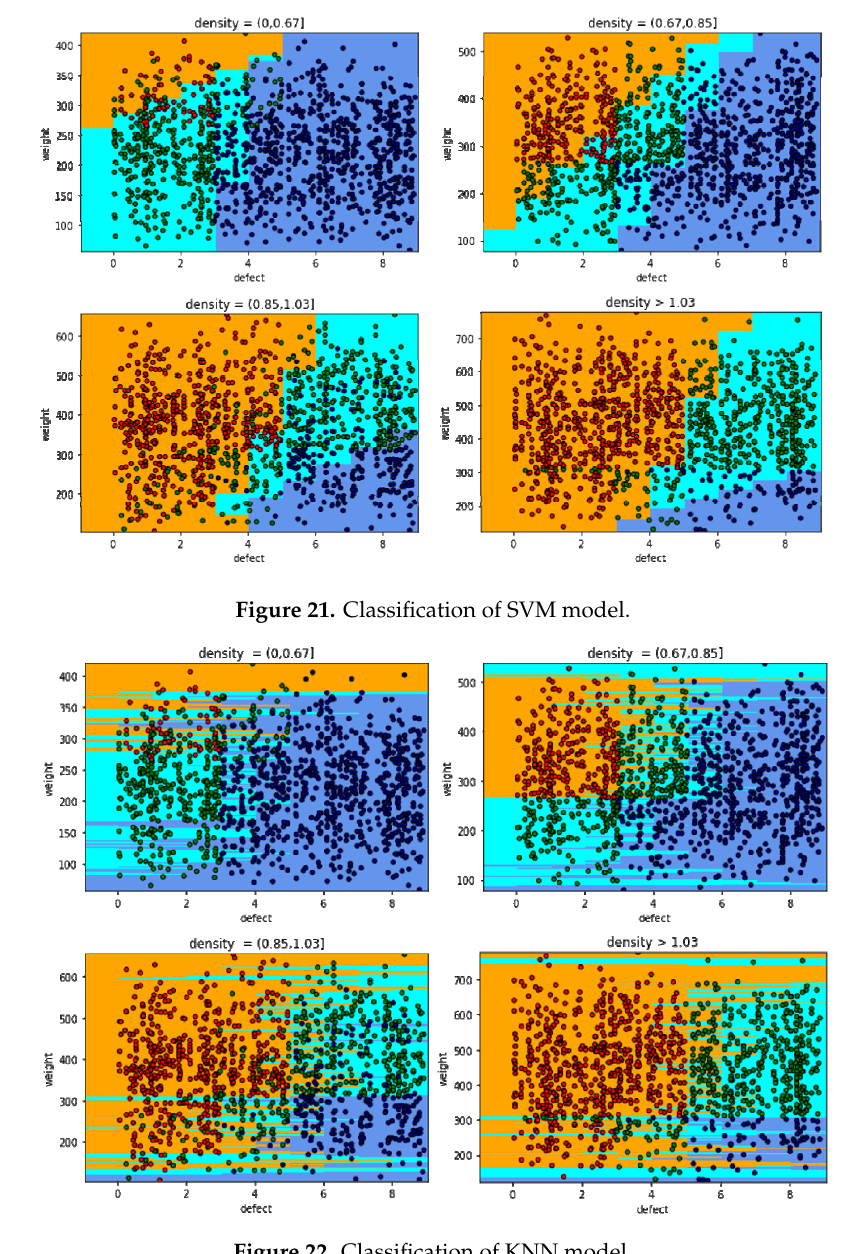
Figure 22. Classification of KNN model.